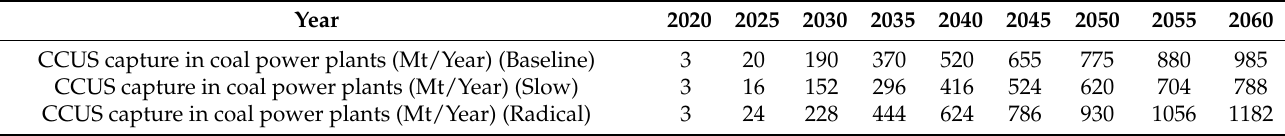
Table 16. Scenario inputs for CCUS carbon capture in